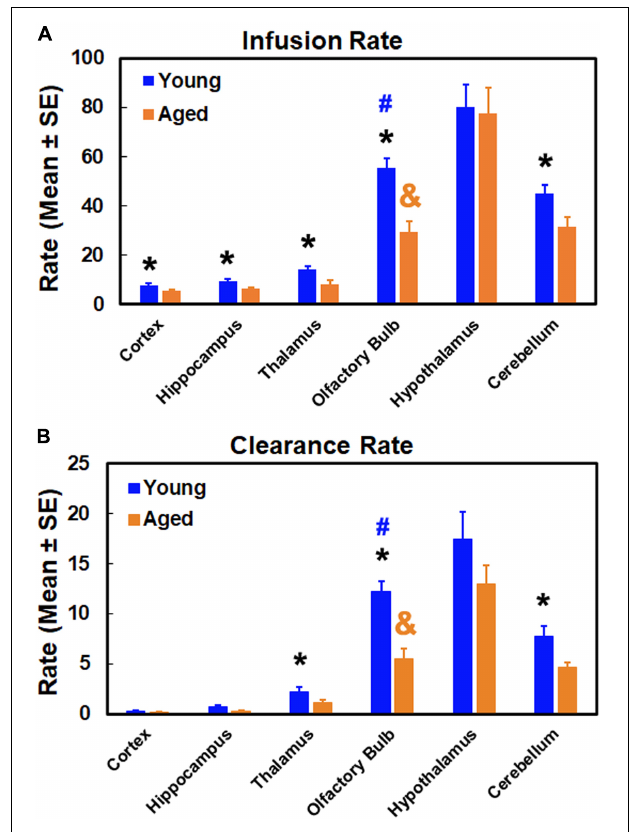
FIGURE 6 | Quantitative results of infusion rate (A) and clearance rate (B) in examined anatomical regions. * p < 0.05, Young vs. Aged in the same region; # p < 0.05, olfactory bulb vs. the other regions in the young group; & p < 0.05, olfactory bulb vs. the other regions in the aged group except the